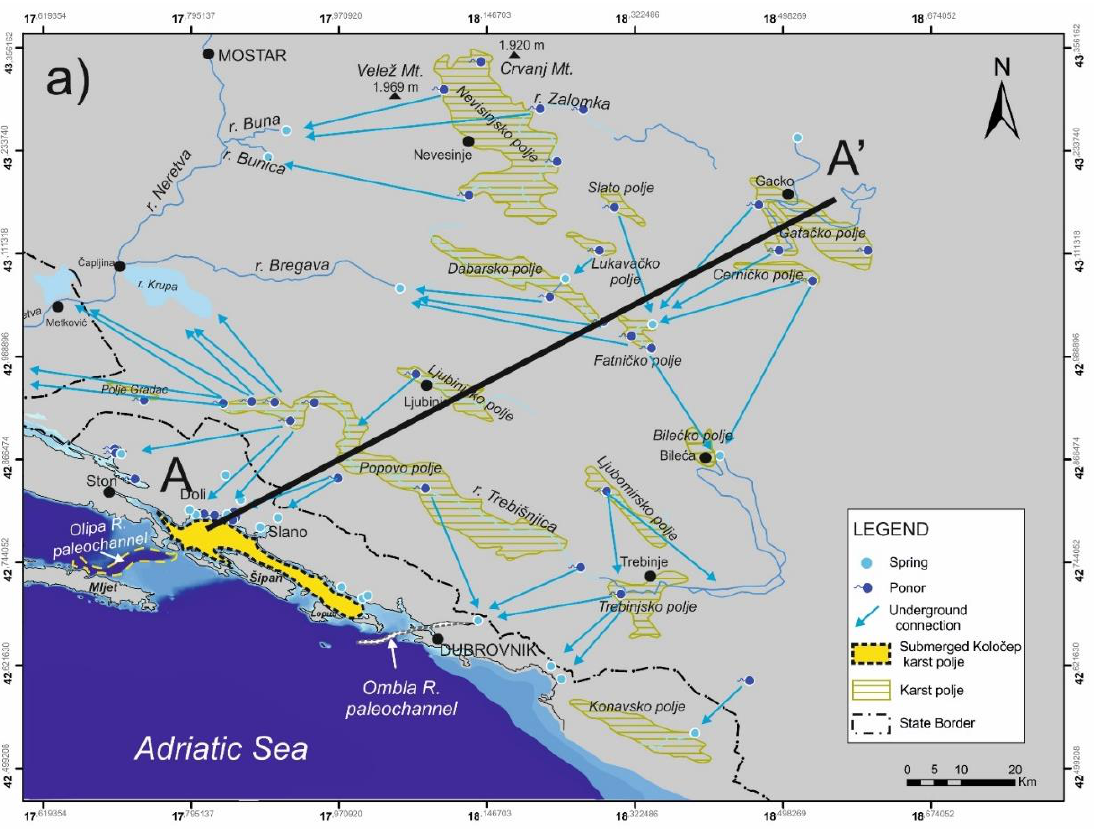
Figure 3. ( a ) Wide area of Doli – Slano littoral with larger karst poljes in the hinterland. Scattered appearances of ponors and springs and their underground connection (modified from [27,28,54]). ( b ) A –A’ : schematic typical cross-section of cascade system through the karstic poljes of Dinarides (modified from [54]); B: recorded multibeam data; and C: recent submarine springs (vrulja) in the Doli – Slano area (photo taken by S. Miko). 3. Materials and Methods 3.1. High-Resolution Seismic Survey A total of 208 km of high-resolution seismic profiles were collected in April 2016 and are presented in this paper . They were recorded with the motorboat “Božja providnost II”. In to- tal, 74 homogeneously distributed seismic lines (Figure 1) within Koločep bay were acquired with a 3.5 kHz ORE Pinger sub-bottom profiler (SBP) for the investigation of the preserved sediment sequence (GeoAcoustics Ltd., Great Yarmouth, UK). SBP data were logged using a Triton SB-Logger (v 7.3, Triton Imaging Inc., Capitola, CA, USA). Due to the dominant (silt) composition of the deposited sediments, the vertical signal penetration reached up to 50 m in the central parts of Koločep bay. The profiler was equipped with two electro -acoustic trans- ducers, serving as both a transmitter and receiver. Obtained data were exported in SEG-Y for- mat, which included the georeferenced reflectance of the acoustic pulse in accordance with